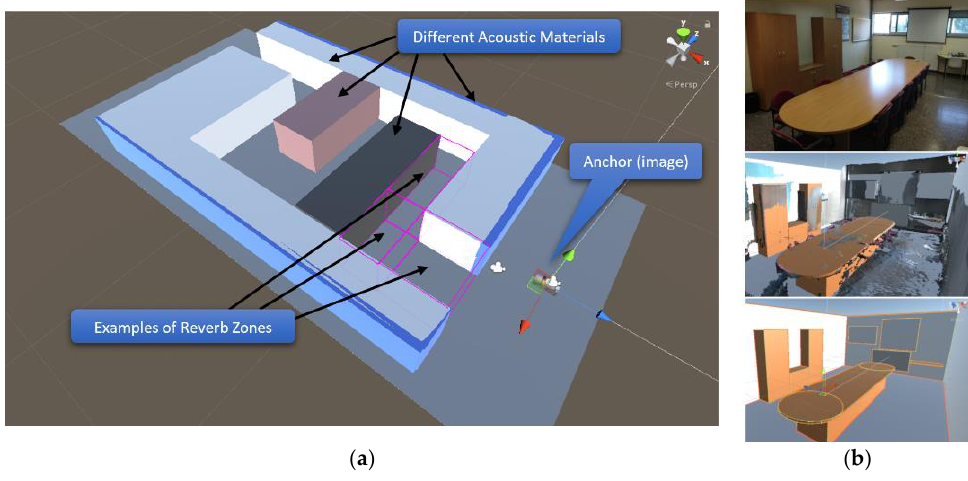
Figure 2. ( a ) Elements of a virtual scenario ( b ) Development of a virtual replica of a real scenario. Up-to-down, the room is recorded with a 3D camera and then is rebuilt with primitives.